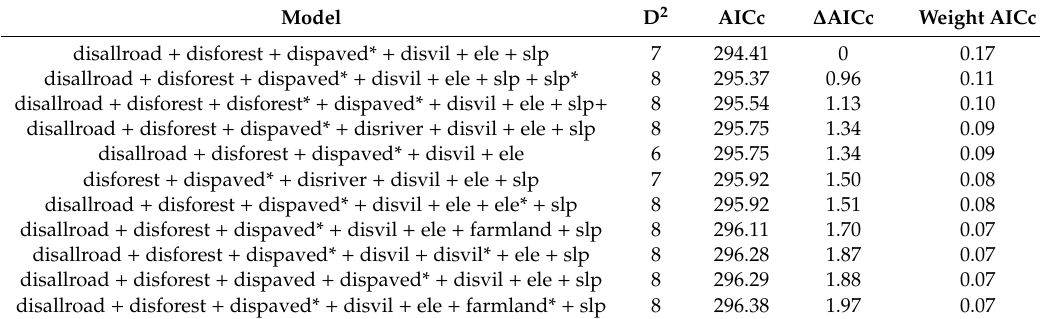
Table 4. The top multi-scale logistic regression models assessing habitat selection by red deer.